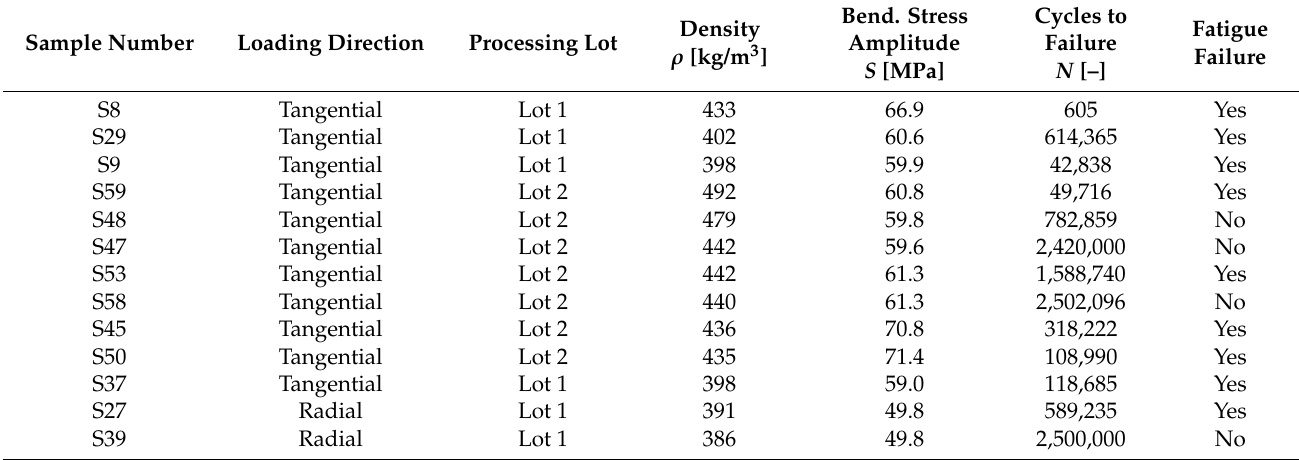
Table 2. Specimen data with the results of the fatigue three-point bending experiments.